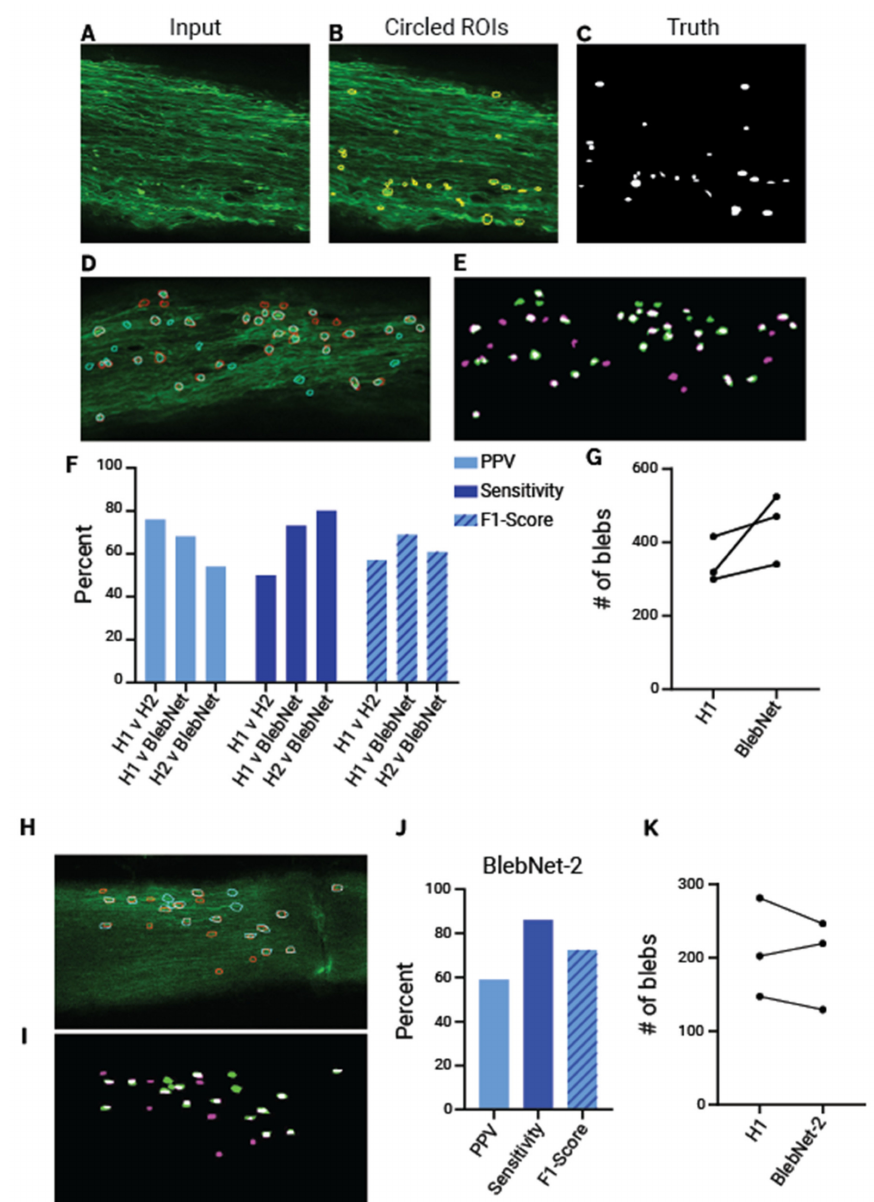
Figure 4. Training and validation of artificial neural net on neurofilament images. ( A – C ) Example of neurofilament labelled image used for training including the input image ( A ), the manually circled bleb ROIs ( B ), and the truth mask used for training based on ROIs ( C ). ( D , E ) Overlay of ground truth (cyan) and BlebNet identified blebs (red) over the raw input image ( D ) and as a mask where green segmentations are ground truth and magenta are BlebNet identified, and white represents the overlap ( E ). ( F ) Percentage positive predictive value, sensitivity, and F1-score for H1 vs. H1, H1 vs. BlebNet, and H2 vs. BlebNet. ( G ) Total number of blebs counted for three separate nerves between H1 and BlebNet. Overlay of ground truth (cyan) and retrained BlebNet-2 identified blebs (red) superimposed over the raw input image of neurofilament labelled nerve with optic nerve crush ( H ), and as a mask where green segmentations are ground truth, magenta are BlebNet-2 identified, and white represents the overlap ( I ). ( J ) Percentage positive predictive value, sensitivity, and F1-score for the retrained BlebNet-2 versus H1. ( K ) Total number of blebs counted for three separate nerves between H1 and the retrained